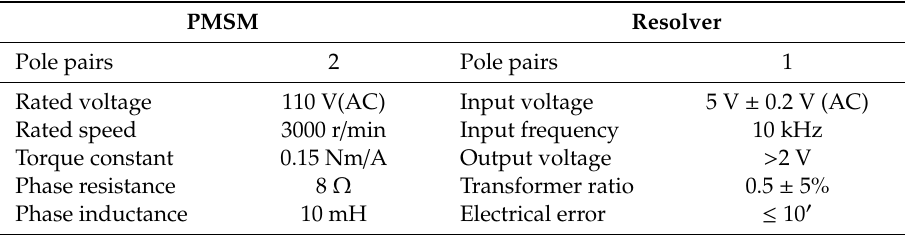
Figure 11. Experimental platform. Table 4. PMSM and resolver parameters.